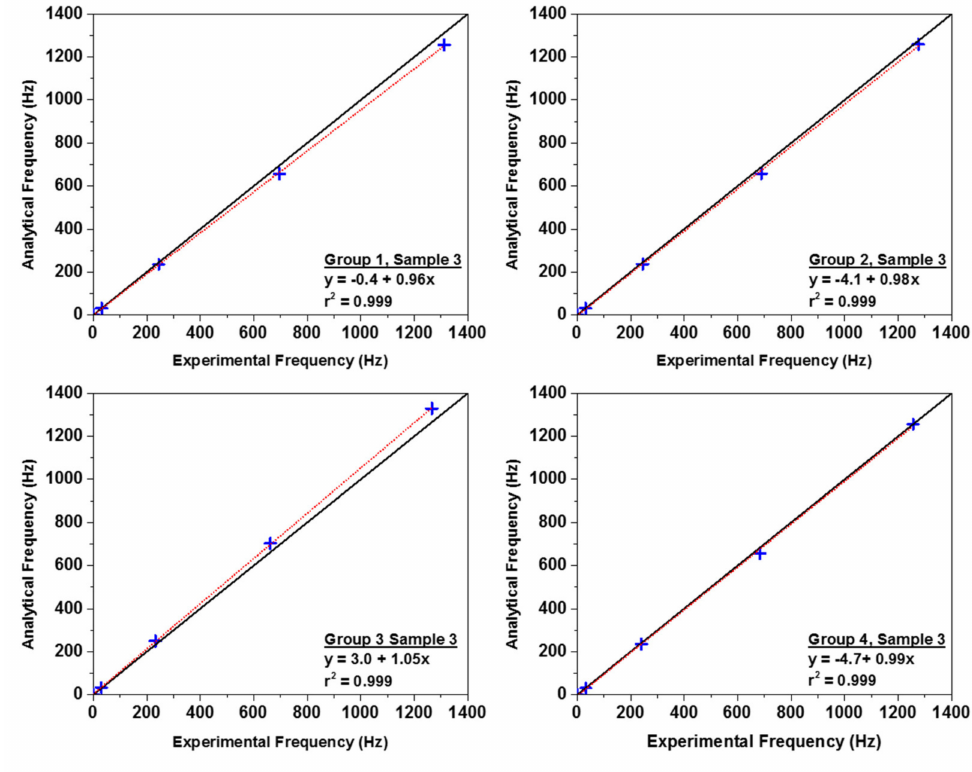
Figure 13. Correlated mode pairs for sample 3 of all groups. The black diagonal line represents a slope equal to